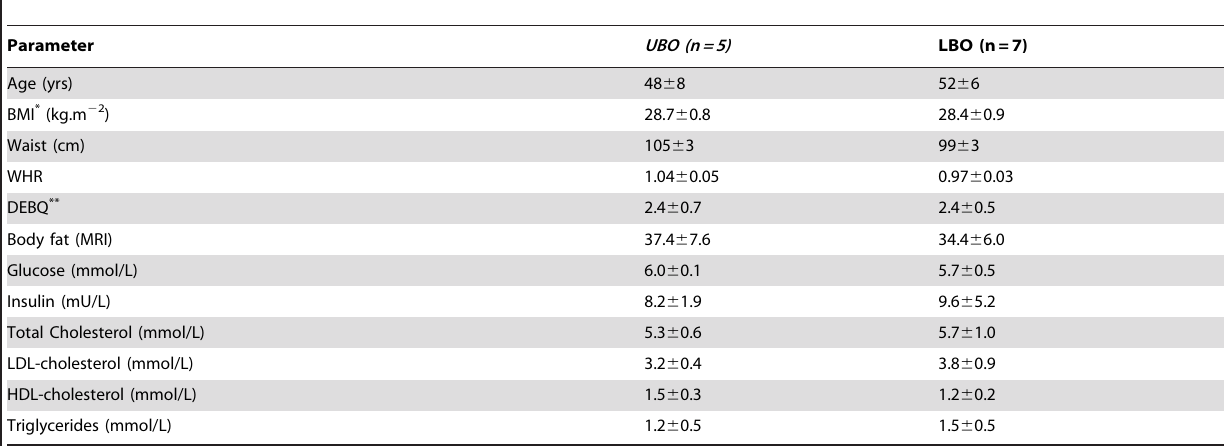
Table 1. Baseline characteristics of the 12 male subjects (mean 6 sd).